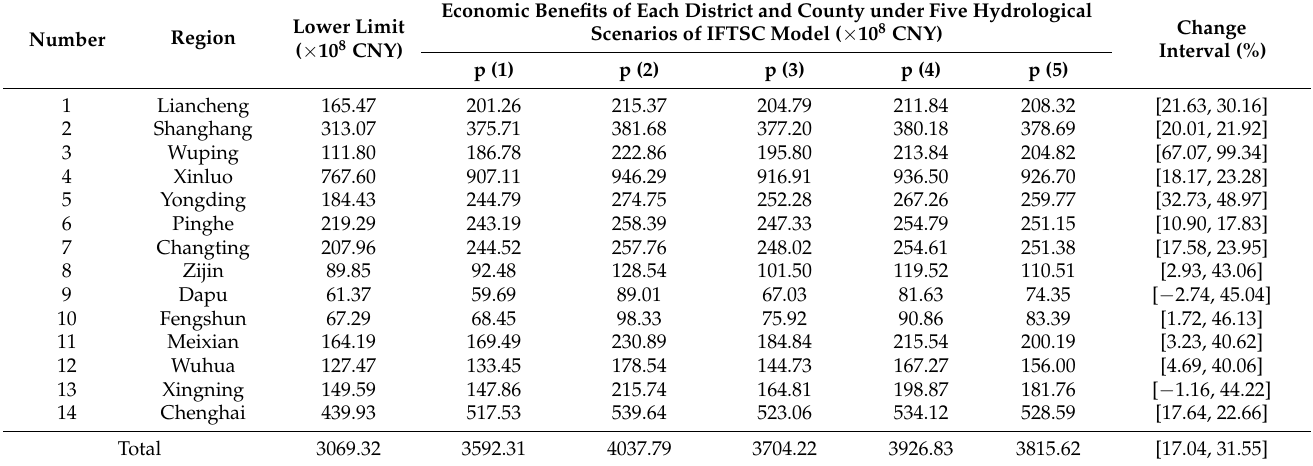
Table 3. Economic benefits of each district and county under five hydrological scenarios simulated by IFTSC (lower